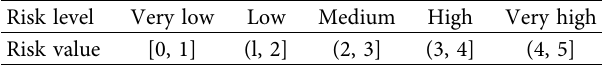
Table 1: Risk level quantification